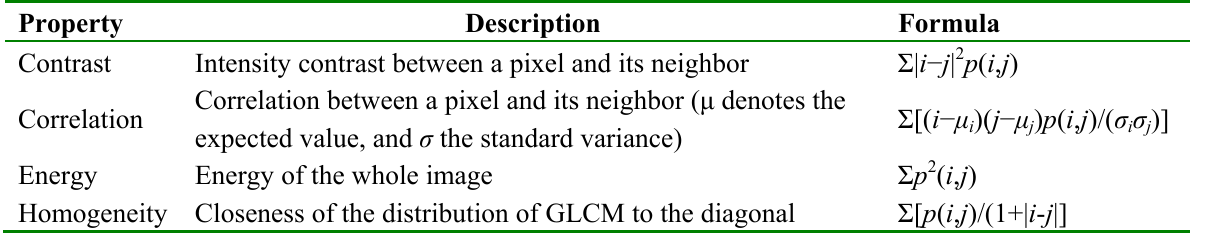
Table 2. Properties of